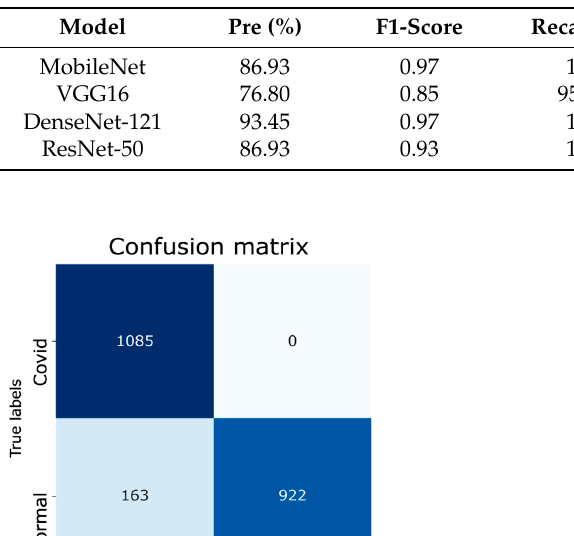
Table 5. Comparison of performance parameters of CNN models.